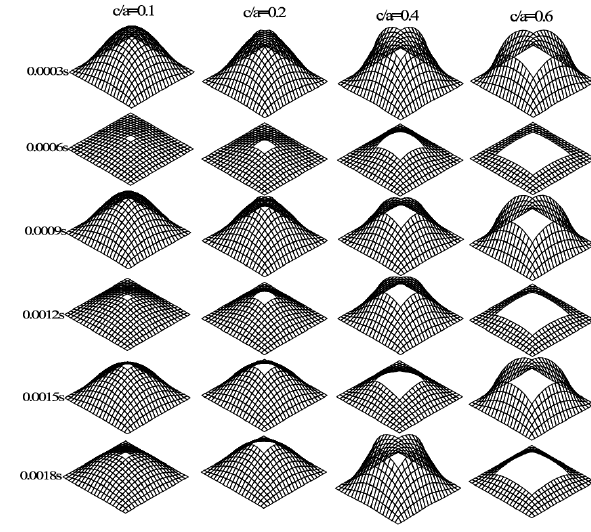
Figure 8: Nonlinear dynamic behaviors ( w / h ) of SWCNT reinforced composite spherical shells for different cutout sizes ( q = 1.0 MPa, [45/ − 45] s , V f = 0.8 , w cnt = 1.0%